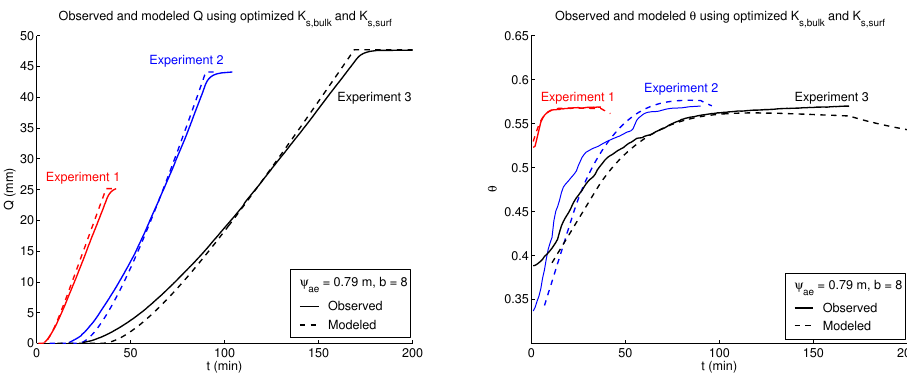
Figure 11. Observed and modeled Q and θ based on optimized hydraulic conductivities for the three experiments with ψ ae = 0 . 79m and b = 8. Optimized hydraulic conductivity values are as follows: experiment 1: K s , surf = 16 . 5mmh − 1 , K s , bulk = 11 . 8mmh − 1 ; experiment 2: K s , surf = 8 . 56mmh − 1 , K s , bulk = 7 . 48mmh − 1 ; and experiment 3: K s , surf = 4 . 24mmh − 1 , K s , bulk = 8 . 20mmh − 1 .